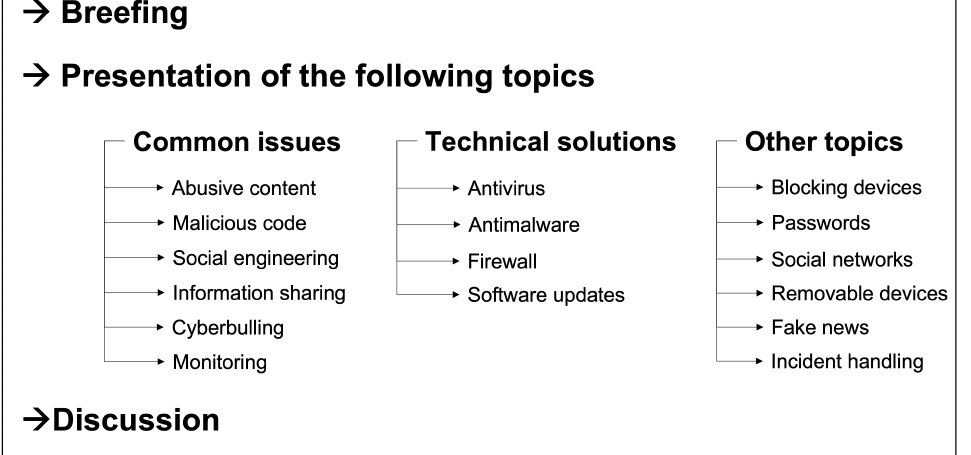
Figure 5. Overall design of the lesson